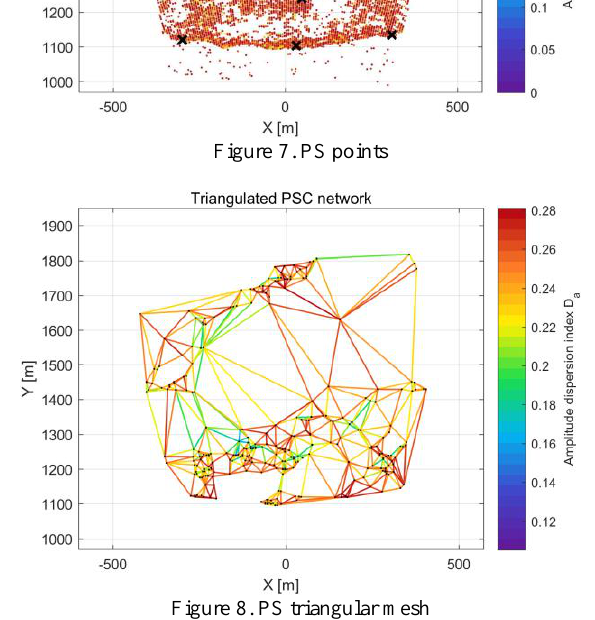
Figure 7. PS points